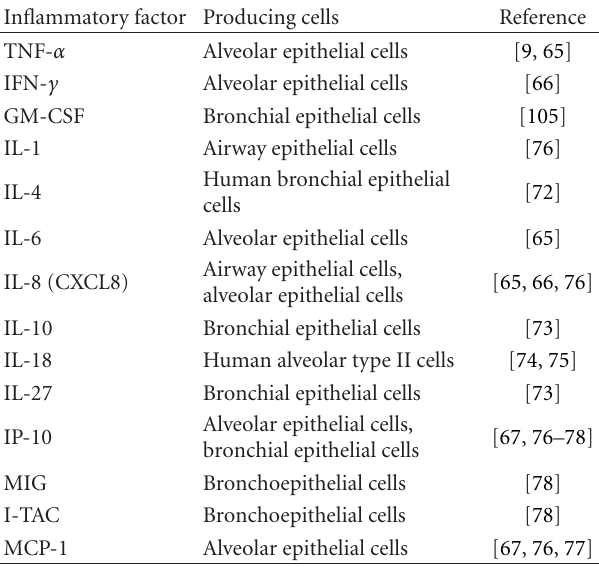
Table 2: Epithelial cell produced chemokines and cytokines against mycobacteria